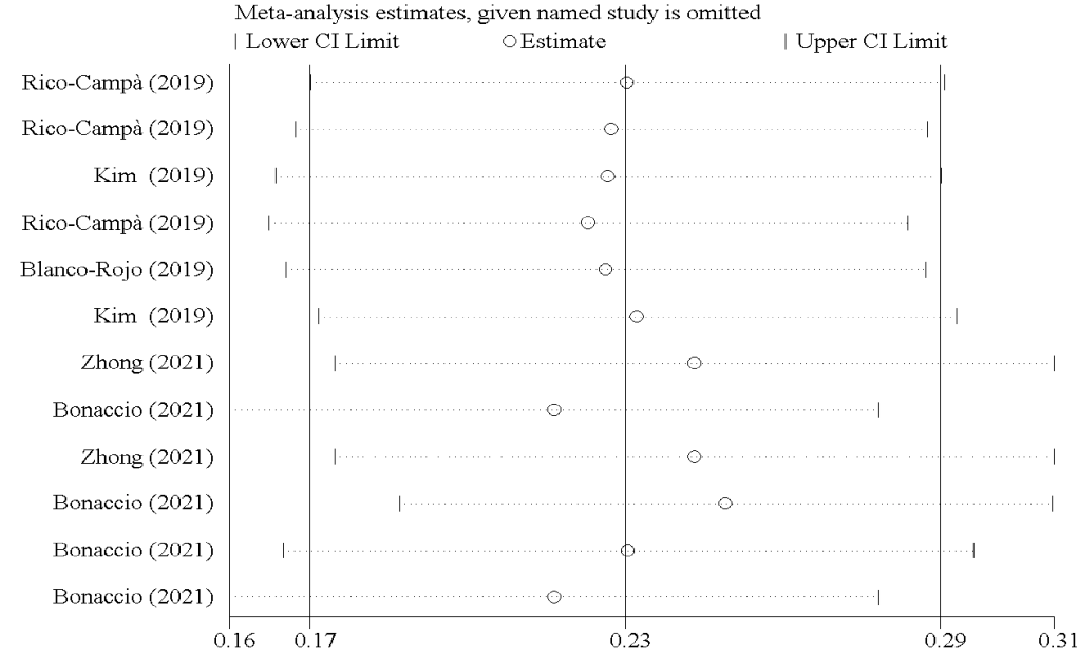
Figure 5. Forest plots showing sensitivity analysis results.